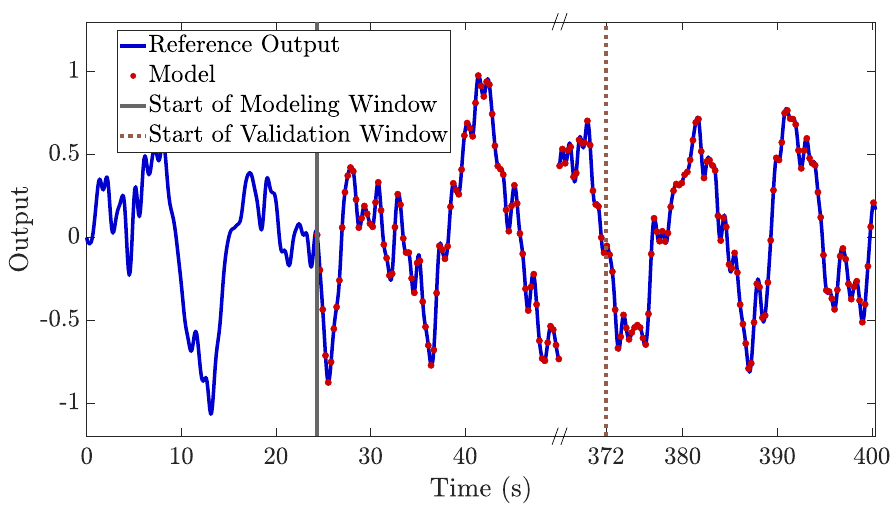
Figure 1. Time domain modeling results for a synthetic test case with P = 2. The modeling window starts after 24 s, the validation window starts at 372